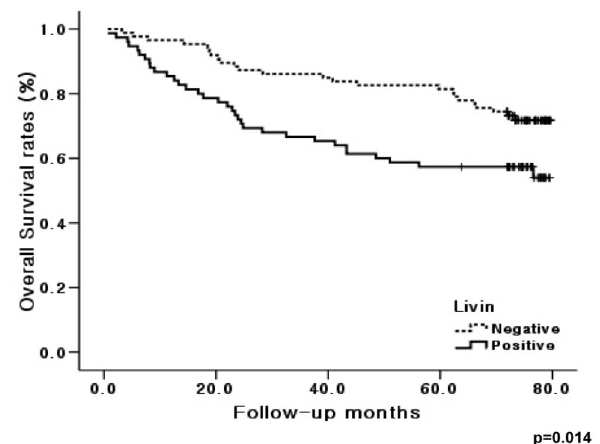
Figure 8. Kaplan-Meier survival curve correlating overall survival with positive expression (solid line) and negative expression (dotted line) of Livin